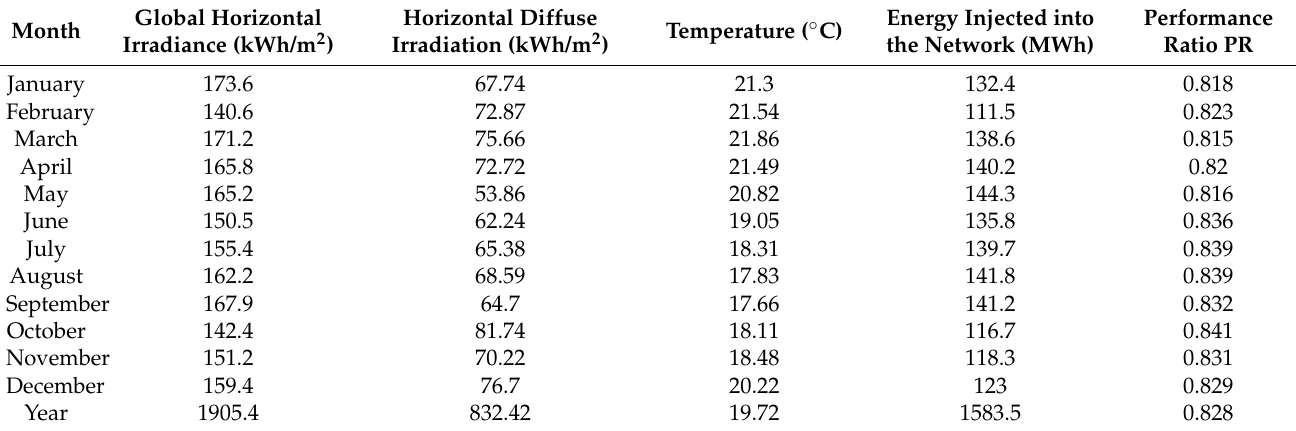
Table 2. Summary of simulated parameters for photovoltaic solar generation.